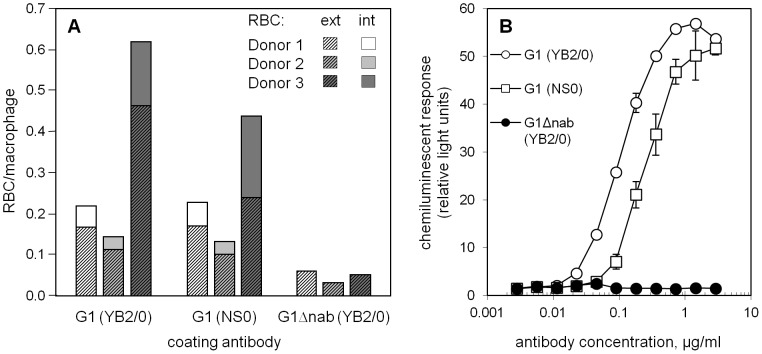
Interactions of Fog-1 IgG-sensitised RBC with monocytes and macrophages.
A The numbers of adherent (ext) and phagocytosed (int) RBC per macrophage were determined for RBC sensitised with saturating concentrations of Fog-1 IgG. Results are shown for macrophages from three different donors. The numbers of unsensitised RBC associating with macrophages were typically 15- to 20-fold lower than the numbers of Fog-1 G1 (YB2/0)-sensitised RBC. B The mean chemiluminescent response of monocytes to sensitised RBC is plotted with the error bars indicating the range of the duplicate samples.